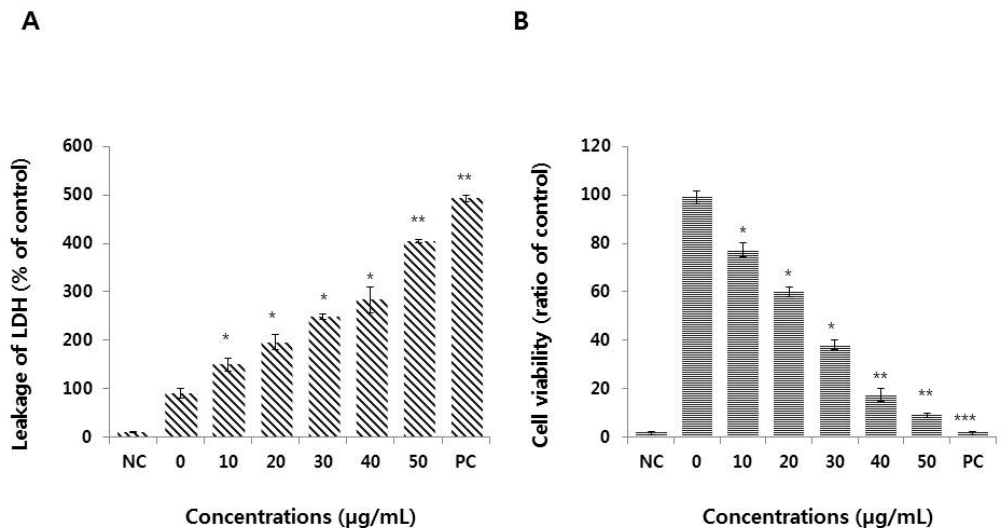
Figure 3. Measurement of lactate dehydrogenase (LDH) leakage and cell death-dependent protease activity in HEK293 cells. ( A ) LDH activity was measured at 490 nm using an LDH cytotoxicity kit. ( B ) The level of released dead-cell-dependent proteases was determined by the CytoTox-Glo cytotoxicity assay. The results are expressed as the means ± standard deviation of three independent experiments. There were significant differences in the levels of LDH and protease activity between graphene oxide-treated cells and untreated cells. * p < 0.05 was considered significant; ** p < 0.01 was considered highly significant and *** p < 0.001 was considered very highly significant.